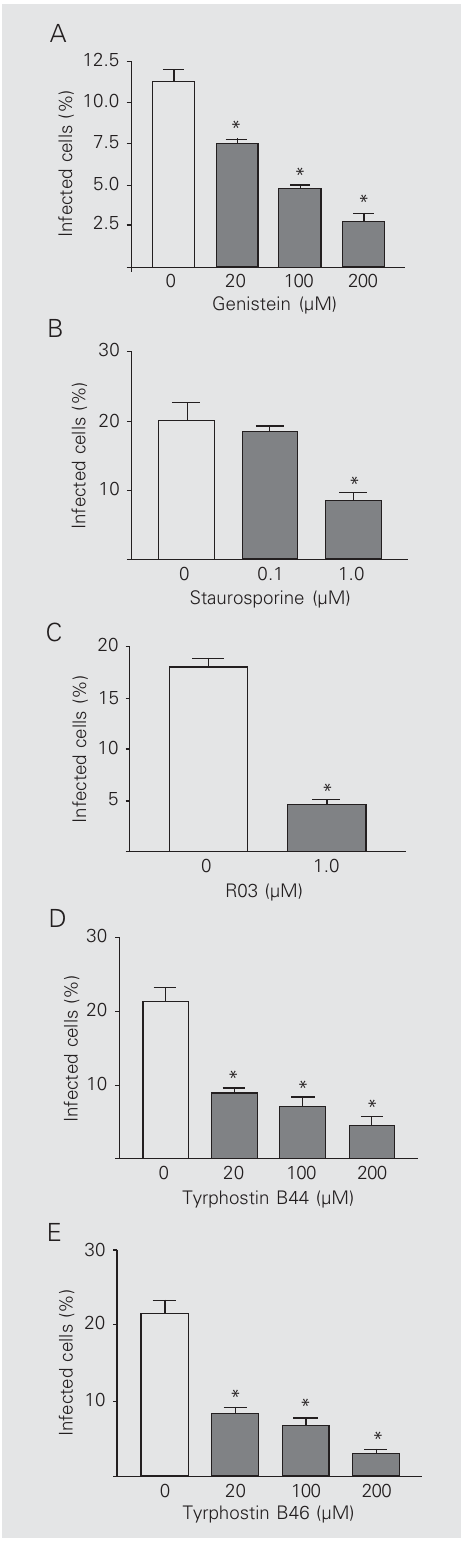
Figure 1. Effect of kinase inhibi- tors on Plasmodium chabaudi cell cycle development in vitro . A , Genistein; B , staurosporine; C , R03; D , tyrphostin B44, and E , tyrphostin B46. The bars indi- cate the percentage of infected red blood cells per 1000 cells after 17-h incubation. Results are reported as means ± SEM for three independent experi- ments. *P < 0.001 compared to control (one-way ANOVA and Newman-Keuls